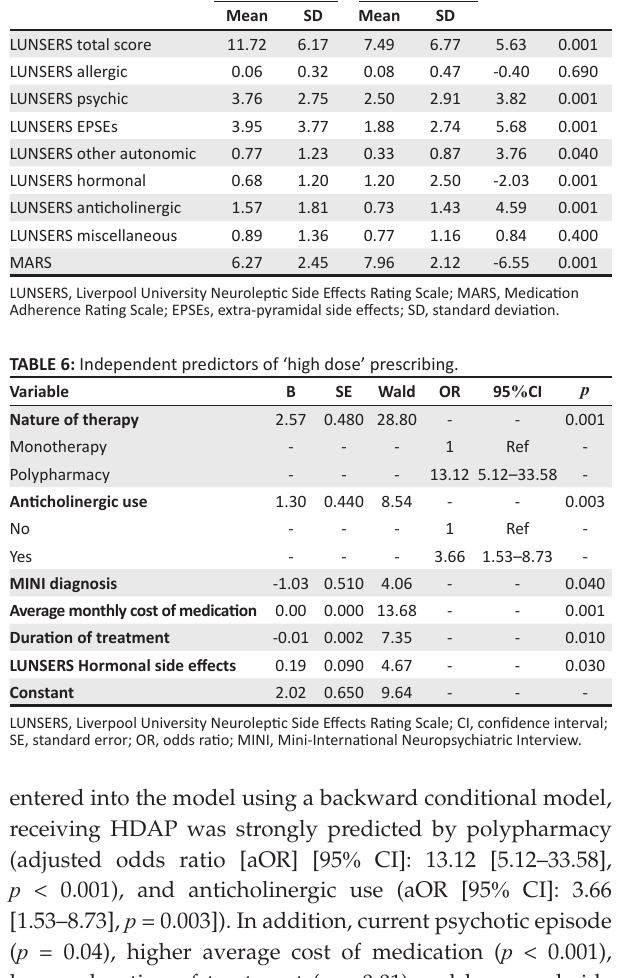
Antipsychotic therapy Monotherapy